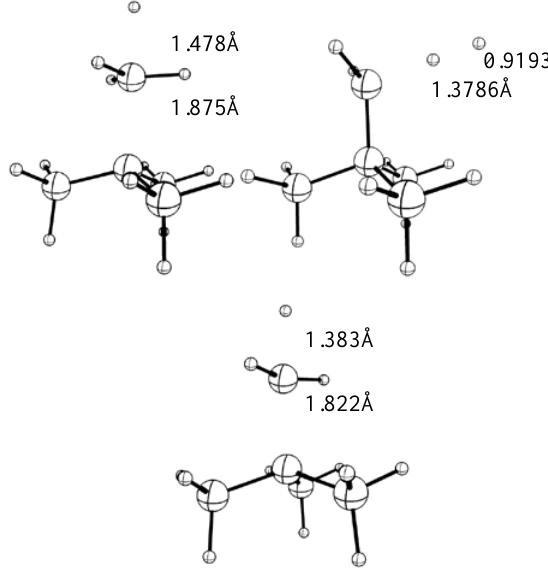
Figure 2. Transition states for the reaction of CH 3 etching by atomic hydrogen, and for a hydrogen recombination, and CH 2 etching in the similar way.